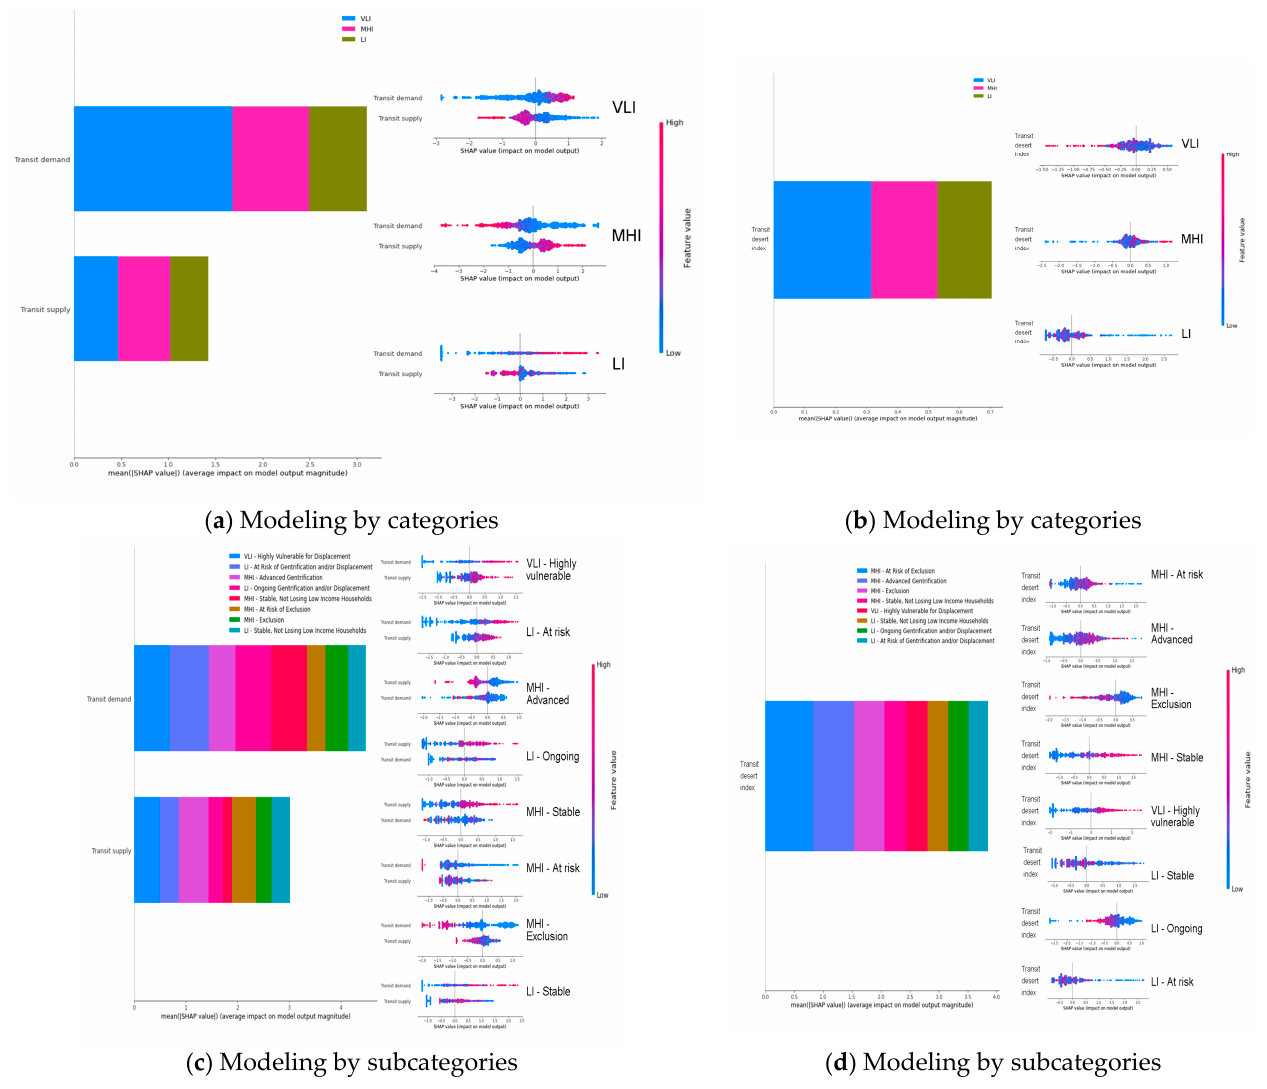
Figure 2. SHAP values of XGBDT results. (a: impacts of transit demand and supply on income cat- egories; b: impacts of transit desert index on income categories; c: impacts of transit demand and supply on gentrification subcategories; d: impacts of transit desert index on gentrification subcate- gories).